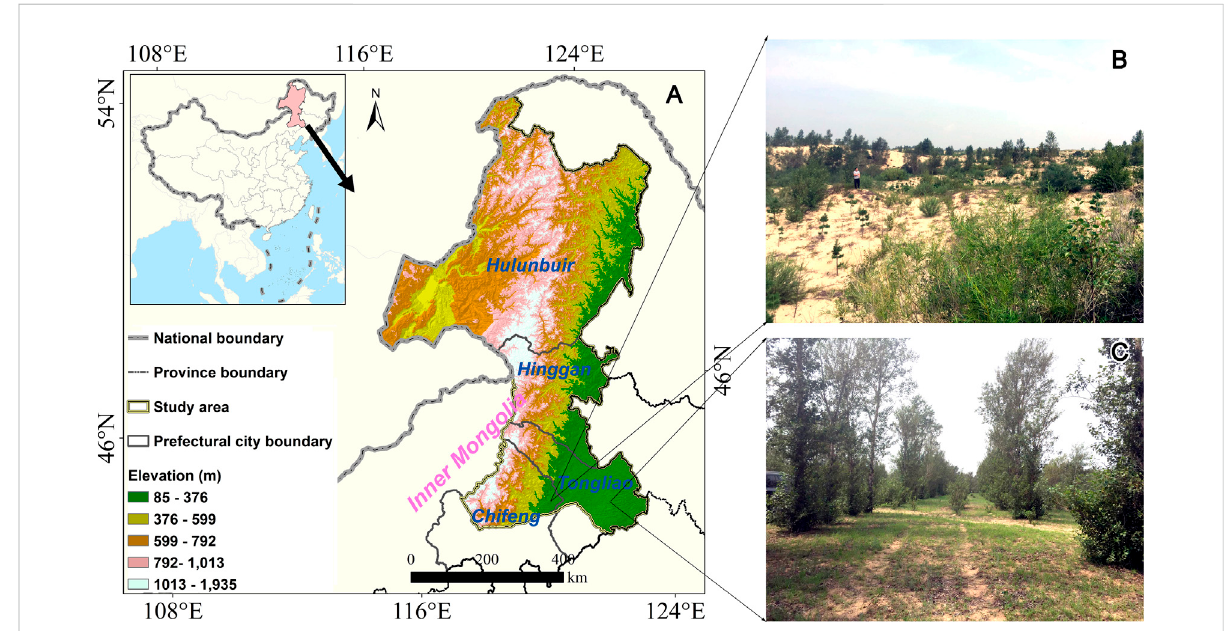
FIGURE 1 The location of the study area. (A) The boundary of Northeast Inner Mongolia. (B,C) Field survey photos after soil erosion control.